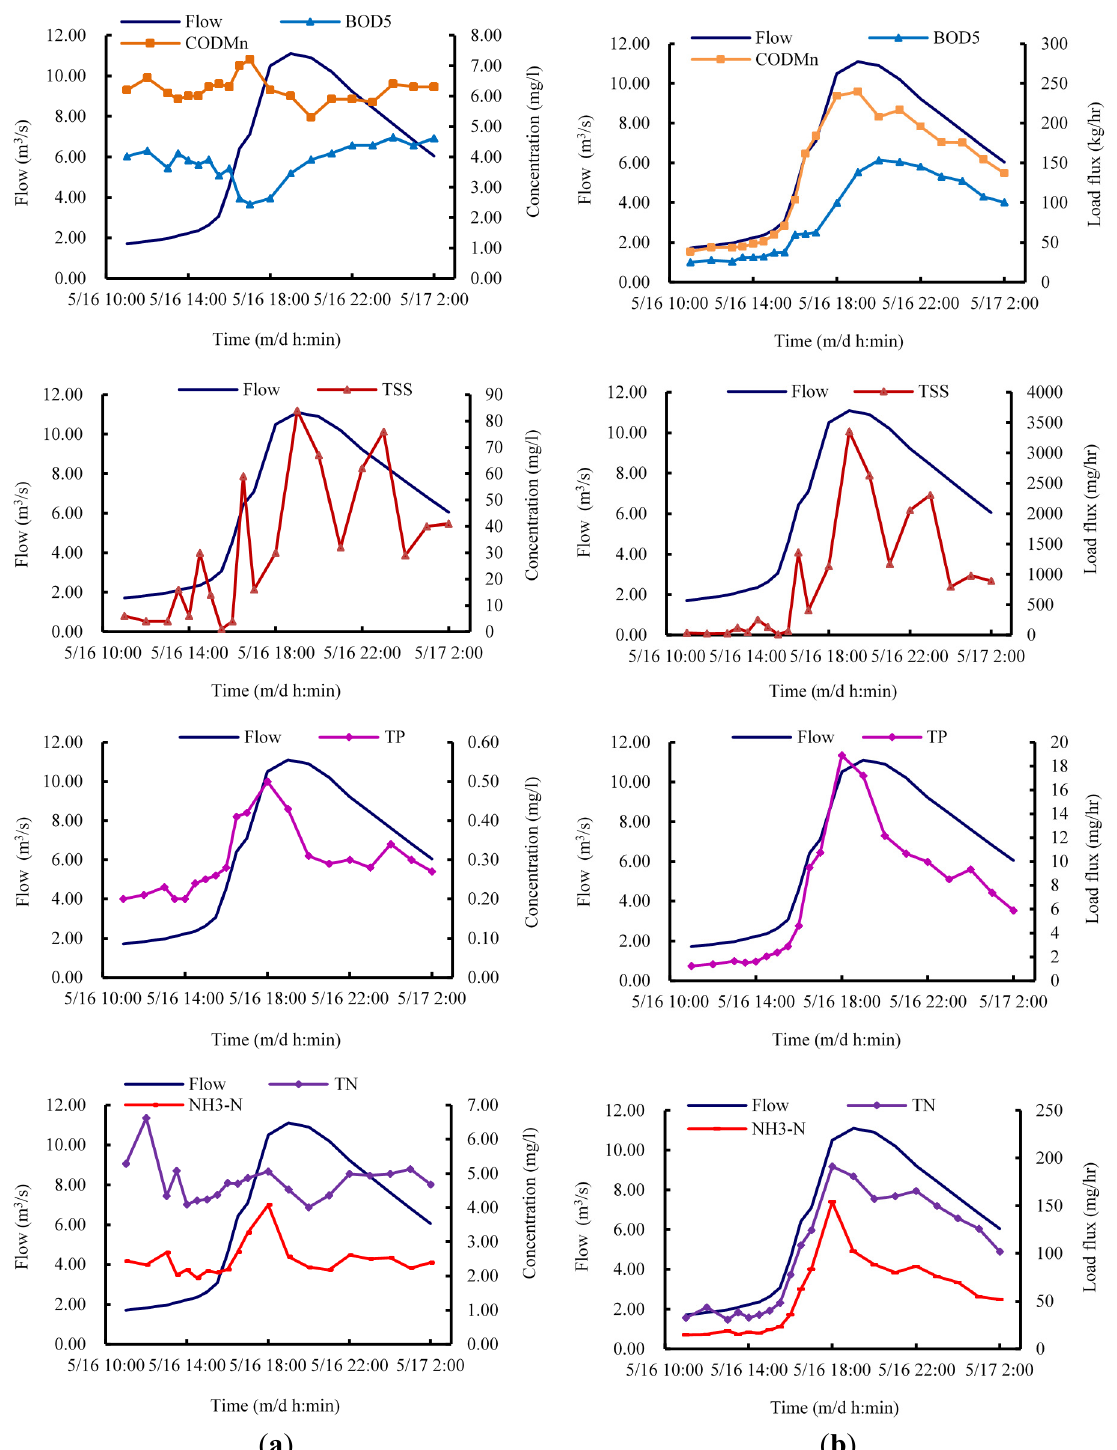
Figure 2. Pollutant concentrations and load fluxes in the runoff from No. 11-05-16